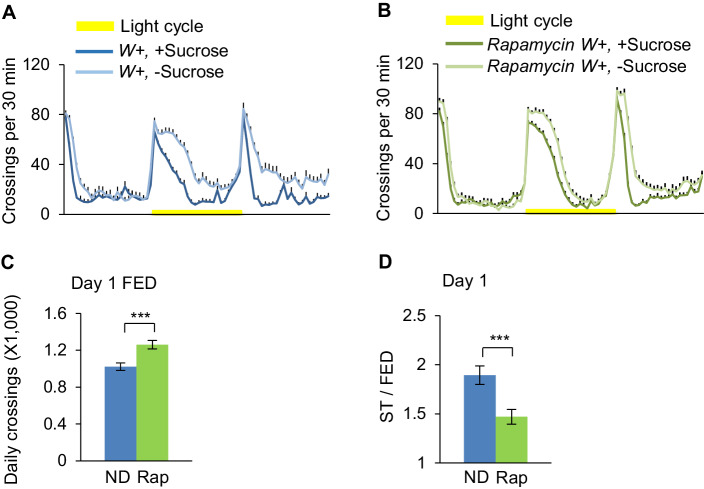
Rapamycin feeding suppresses starvation-induced hyperactivity.Wild-type virgin female flies fed with ND (blue) or ND plus rapmycin (green) were assayed in the presence (dark color) and absence (light color) of 5% sucrose using DAMS-based locomotion assay (n = 48–64). Midline crossing activities of indicated flies are shown in A-B. (C) Average daily midline crossing activity of fed flies assayed in A-B. (D) Starvation-induced hyperactivity of flies assayed in A-B ns, p>0.05; *p<0.05; **p<0.01; ****p<0.0001. Student’s t-test and one-way ANOVA followed by post hoc test with Bonferroni correction were used for pair-wise and multiple comparisons, respectively.